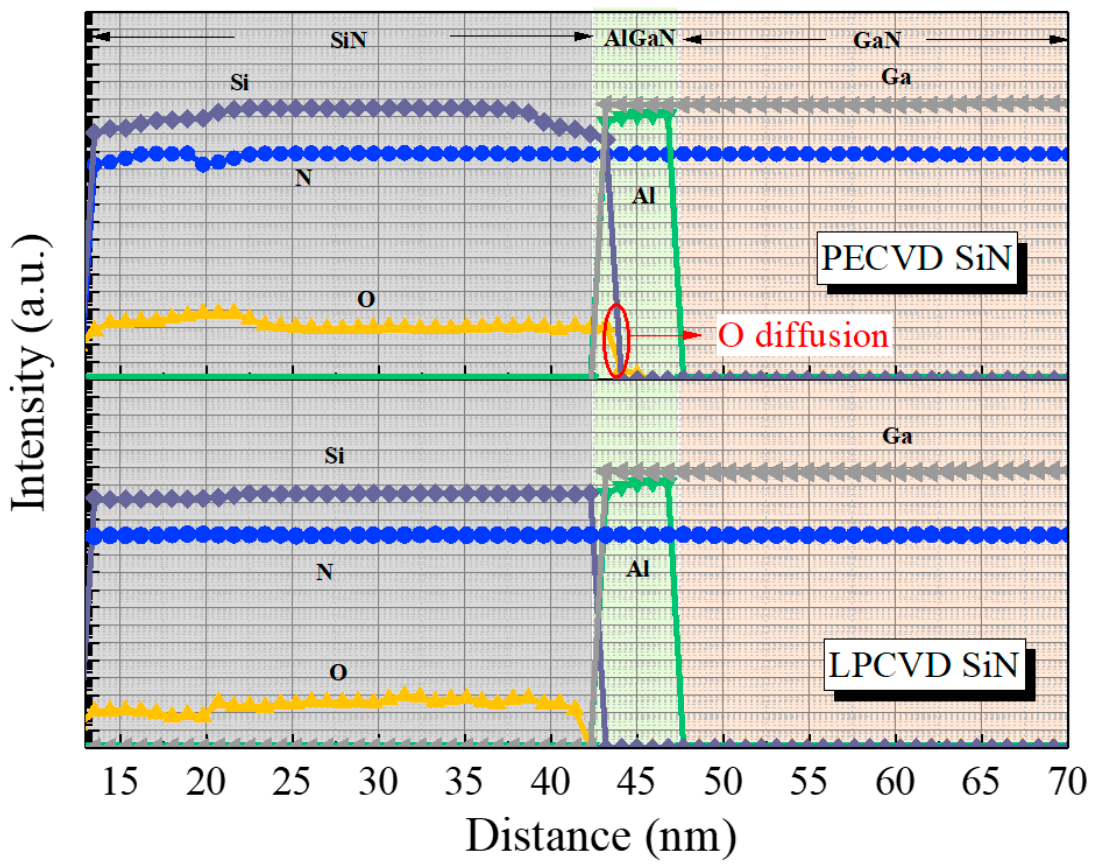
Figure 3. The EDX vertical line scanning images for PECVD- and LPCVD-SiN x passivated UTB MISHEMT.